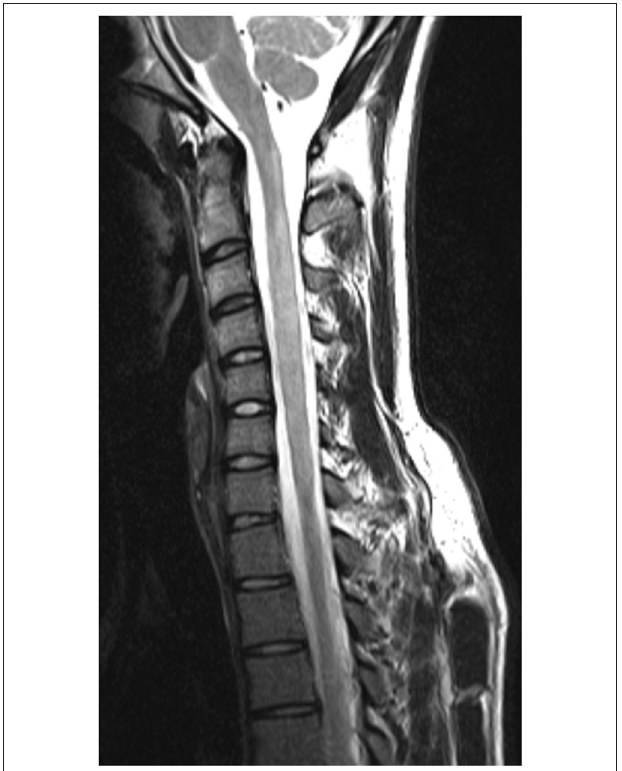
FIGURE 10 | “Pseudo-longitudinally” extensive spinal cord lesion seen in multiple sclerosis. Sagittal T2 MRI of the cervical spine in a multiple sclerosis control showing longitudinally extensive high signal changes extending from C1 to C6. This lesion is confluent over at least 3 vertebral segments. Prior imaging confirmed that this lesion arose as a confluence of smaller lesions over